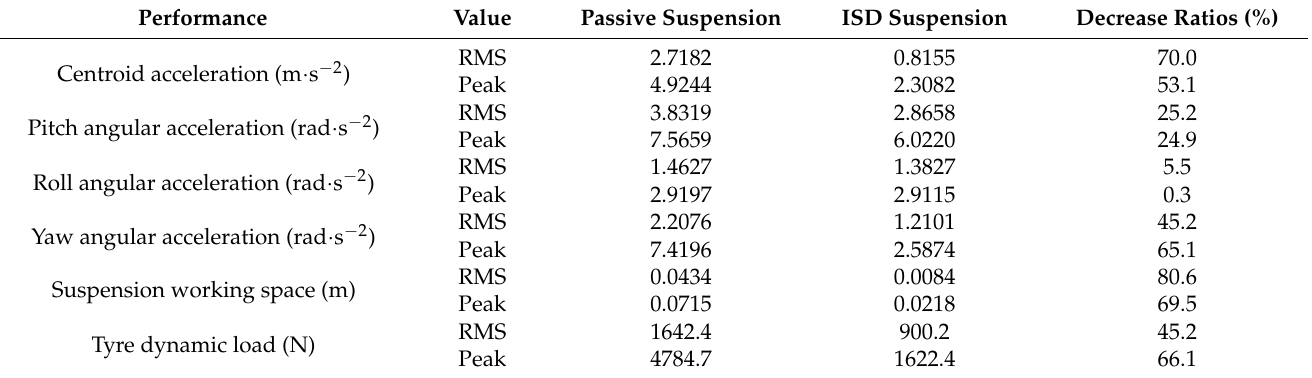
Figure 8. Dynamic characteristics under fitting periodic road excitation: ( a ) centroid acceleration; ( b ) pitch angular acceleration; ( c ) roll angular acceleration; ( d ) yaw angular acceleration; ( e ) suspension working space; ( f ) tyre dynamic load. To quantitatively describe the performance changes, comparison of performance indicators under fitting periodic road excitation is shown in Table 2. Table 2. Comparison of performance indicators under fitting periodic road excitation.